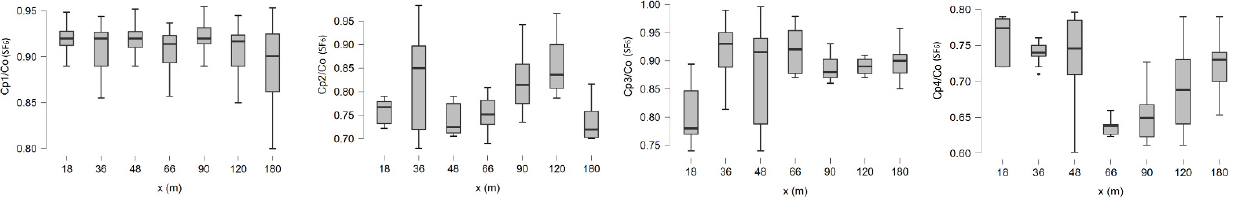
Figure 4. Cp/Co for SF 6 using the Raleigh 2006 NO experiment (Data 2) for unstable atmospheric conditions concerning the downwind distances.